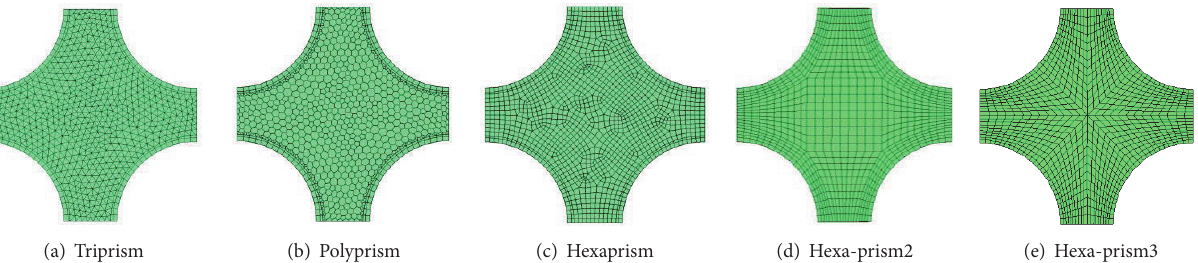
Figure 4: Prim mesh for the simple subchannel region.